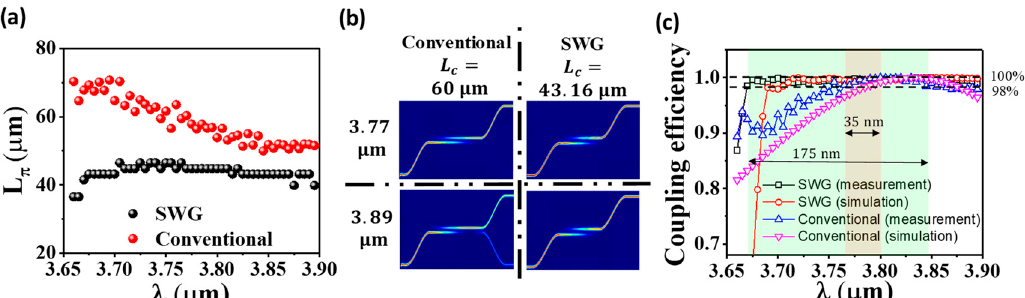
Figure 5. ( a ) Comparison of experimental L π at different λ in conventional DC and SWG-based WFDC. ( b ) The simulated mode profile of conventional DC and SWG-based WFDC at 3.77 µm and 3.89 µm for 100% coupler efficiency. The simulation is performed using Lumerical FDTD Solutions. ( c ) The WF performance of SWG-based WFDC compared with conventional DC for 100% coupling efficiency. The green and red area respectively highlight the operation bandwidth of SWG-based WFDC and conventional DC.